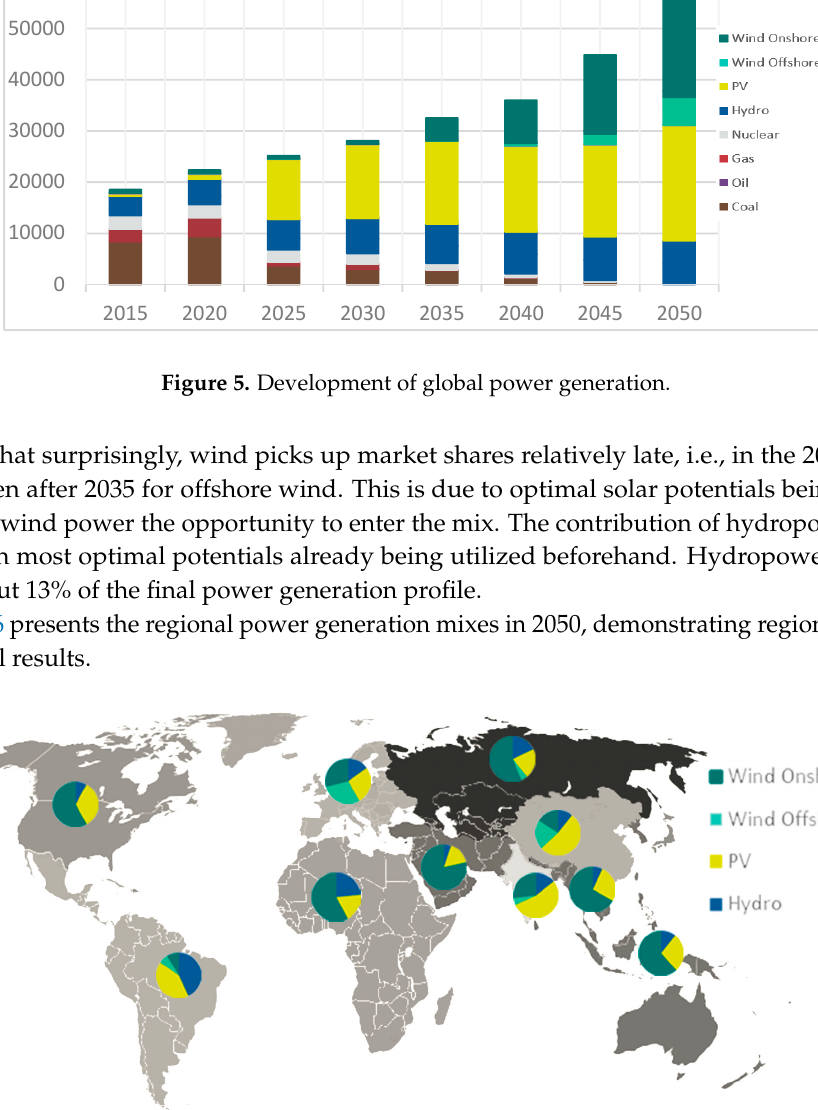
Figure 6. Power generation profiles in 2050.